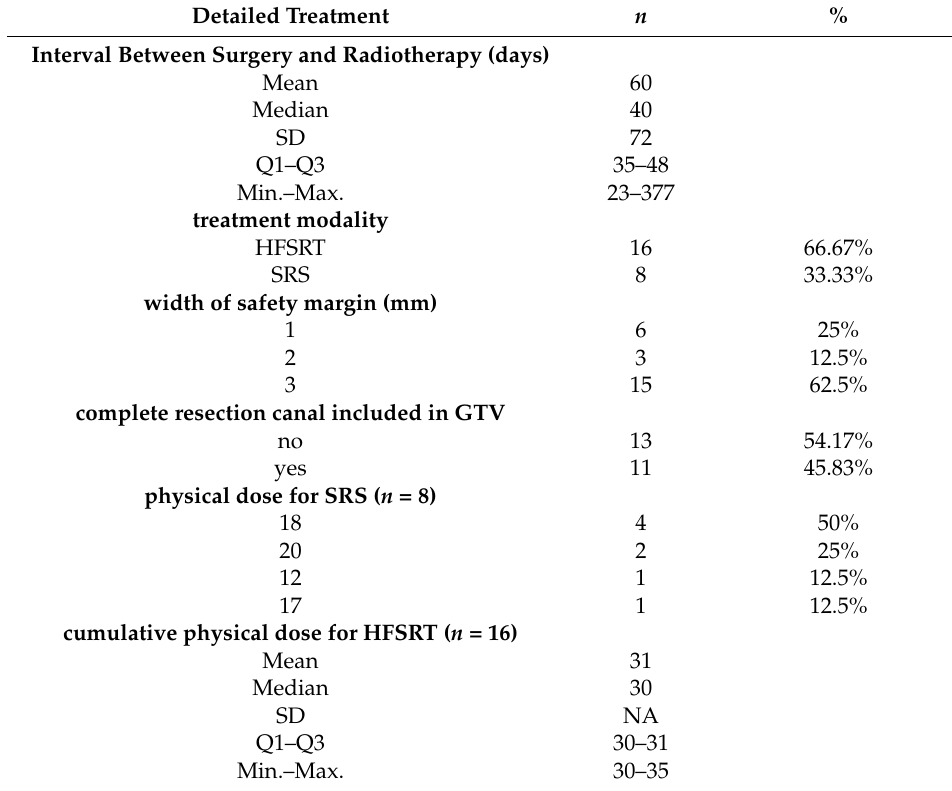
Table 2. Detailed treatment parameters for performed